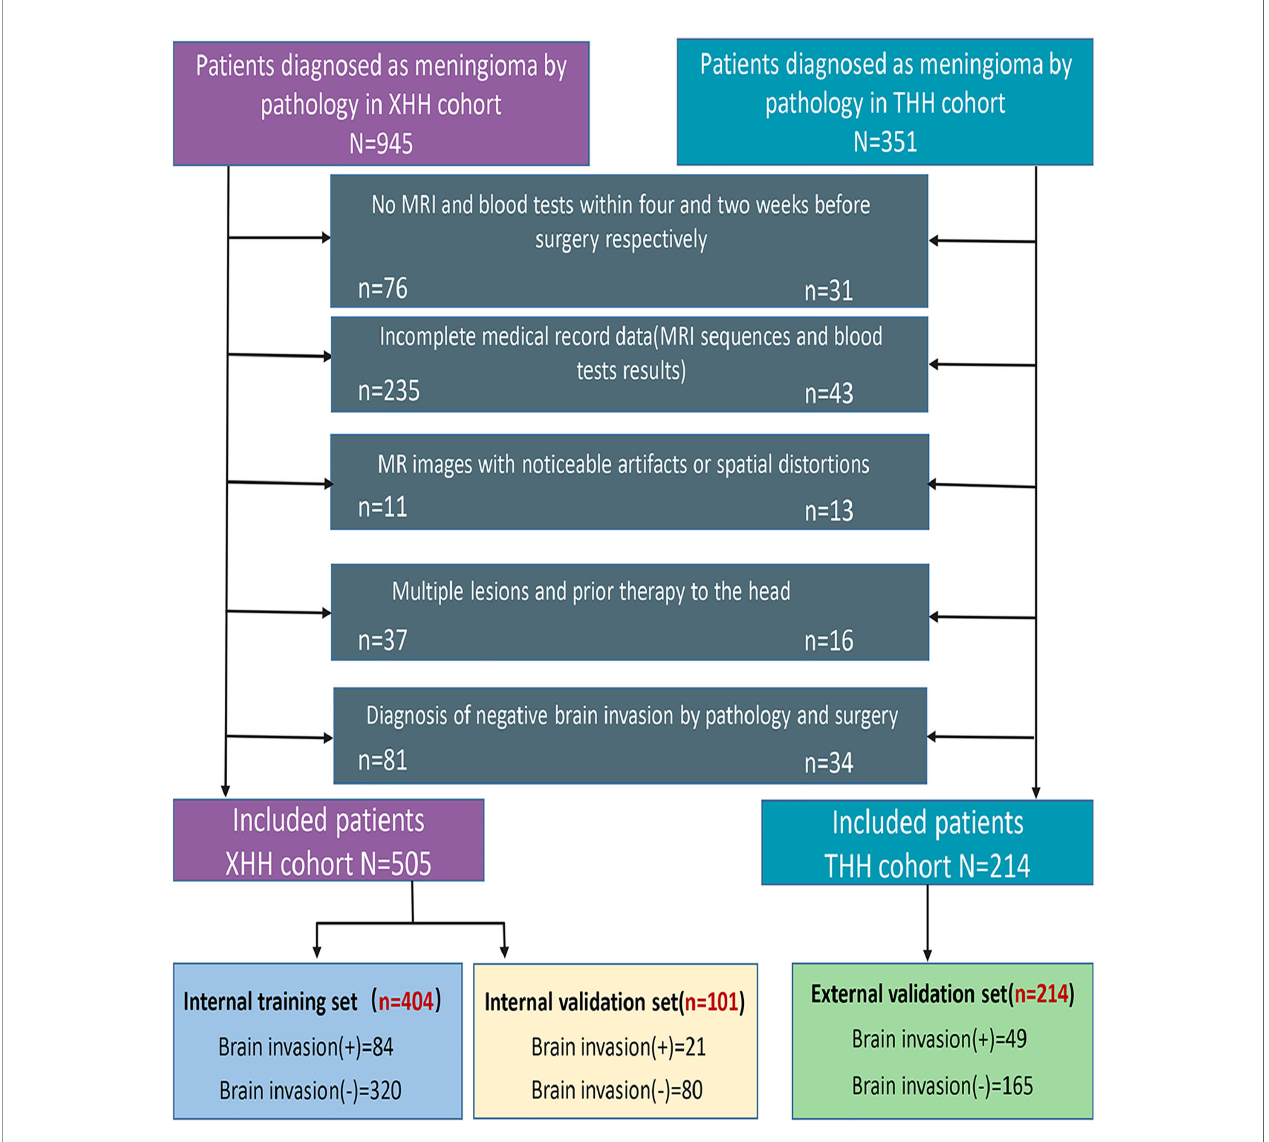
FIGURE 1 | Patient selection